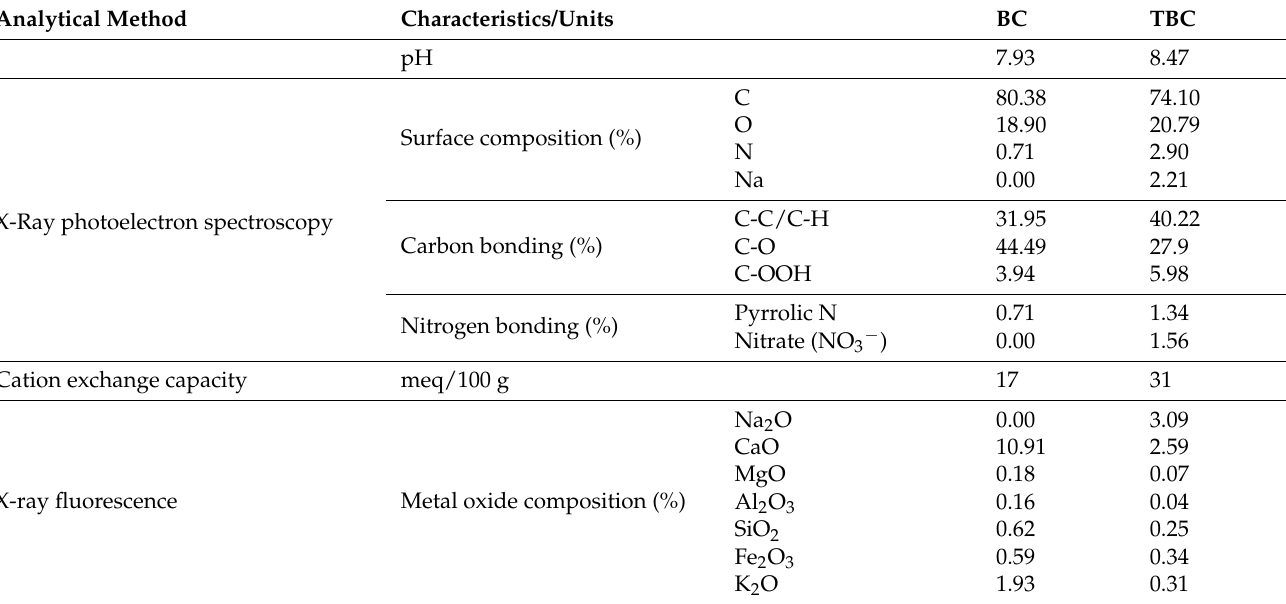
Table 4. Surface and physicochemical analyses of BC and